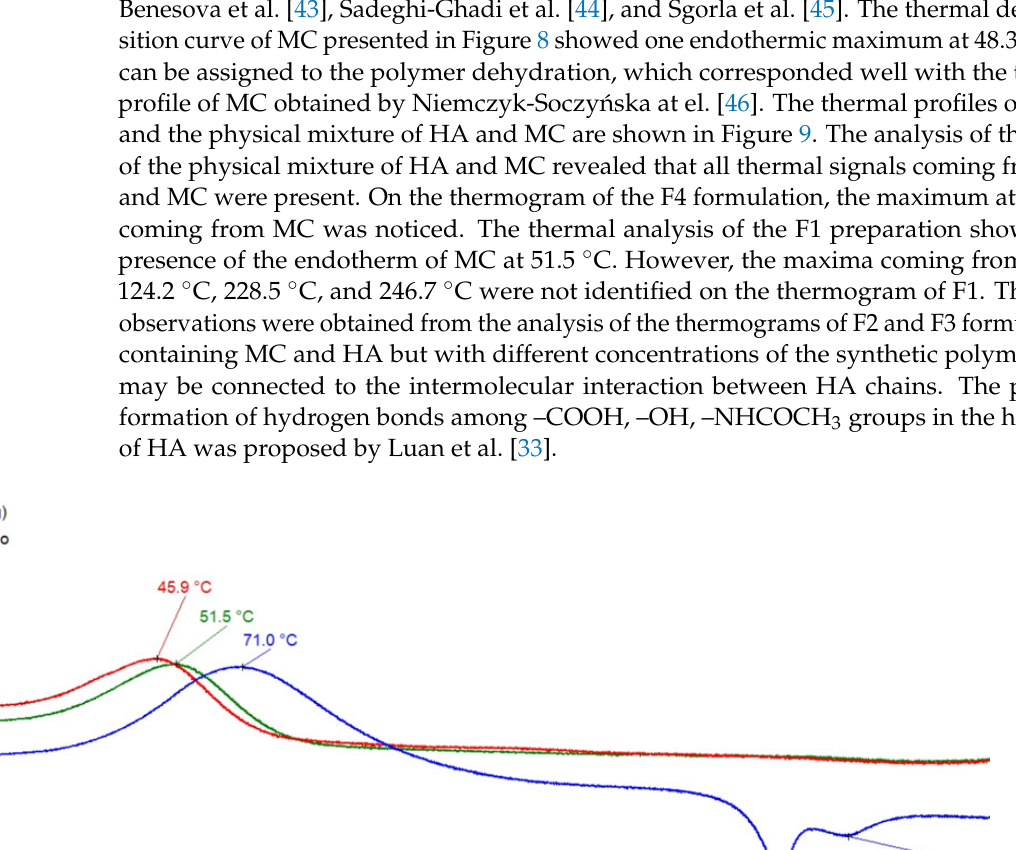
Figure 10. The thermograms of formulation F7 (red), formulation F10 (green), and the physical mixture of HA and PA (blue).